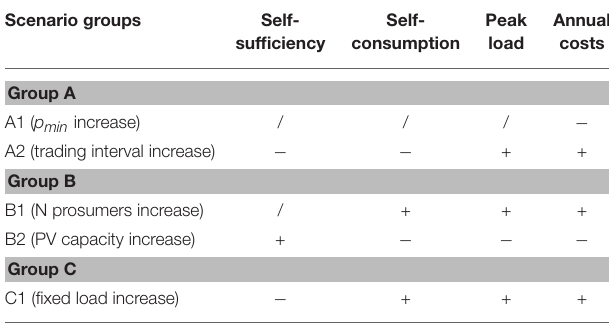
TABLE 4 | Comparison of different scenario groups using the market model at the prosumer